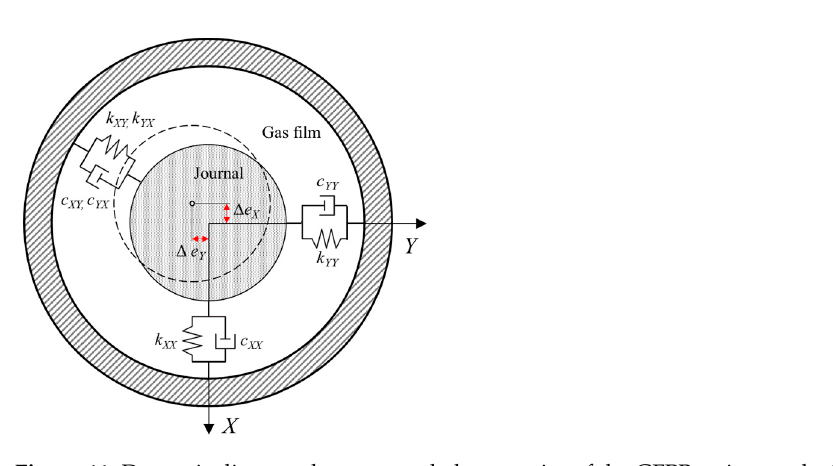
Figure 10. Predicted synchronous force coefficients versus the rotor speed depending on the polymer layer thickness: cross-coupled stiffness coefficients.